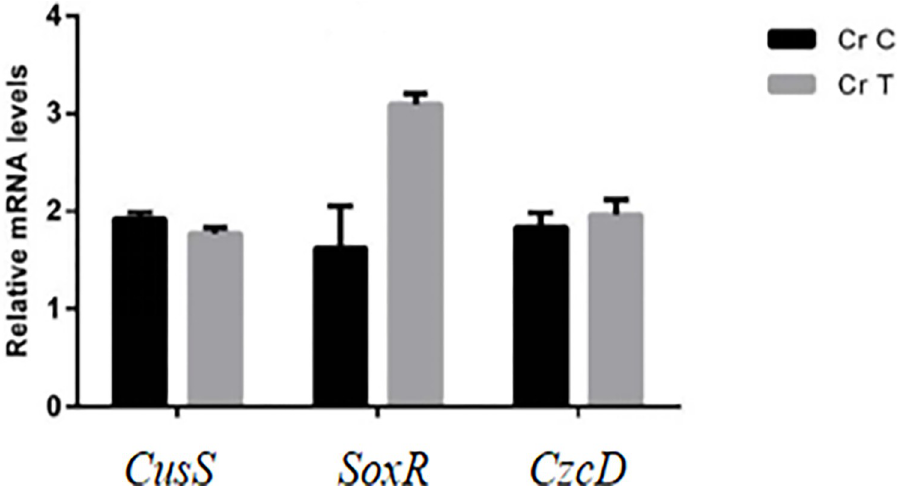
Fig 4. qRT-PCR results of three randomly selected candidate genes. The 16S rRNA gene was used as an internal reference. The data was shown as mean ± standard error (n = 3).